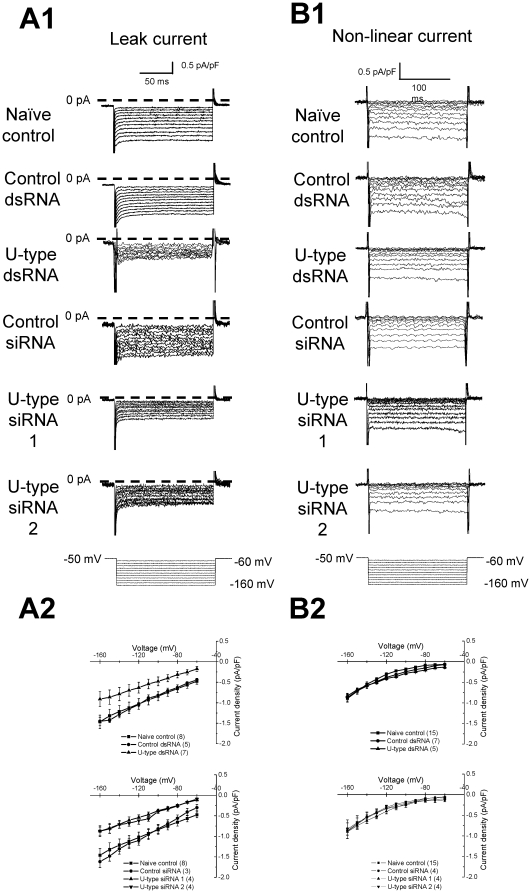
U-type RNAi knockdown reduces inward hyperpolarizing leak currents in
RPeD1 neurons.U-type RNAi treatment reduces inward hyperpolarizing Ileak.
(A1) Representative ILeak, and (A2) average current
density-voltage (I–V) relation of the hyperpolarizing inward
ILeak in RPeD1 cells from naïve control
(n = 8), control dsRNA
(n = 5), U-type dsRNA (n = 7),
control siRNA (n = 3), U-type siRNA 1
(n = 4), and U-type siRNA 2
(n = 4) treated RPeD1 neuron. ILeak at
all hyperpolarizing voltages reduced significantly in the U-type
dsRNA/siRNAs groups as compared to the control groups (P<0.05). (C)
Non-linear leak component was not significantly affected by the U-type
RNAi treatment. (B1) Representative non-linear component, and (B2)
average current density-voltage relations of the non-linear component
for naïve control (n = 15), control dsRNA
(n = 7), U-type dsRNA (n = 5),
control siRNA (n = 4), U-type siRNA 1
(n = 4), and U-type siRNA 2
(n = 4).